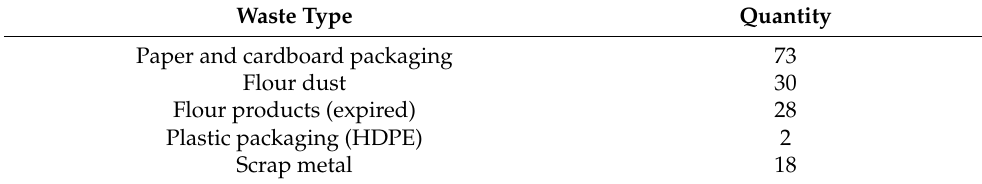
Table 3. Grain mill industry waste streams (in tonnes per year) 1